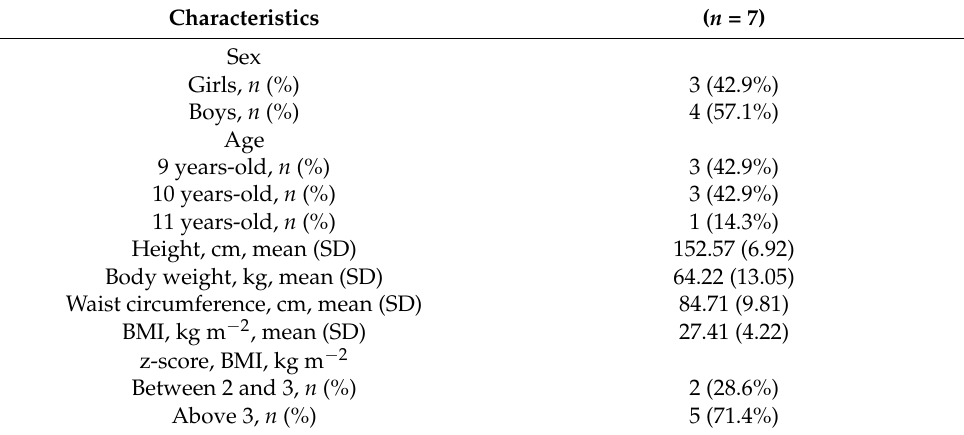
Table 1. Characteristics of the study